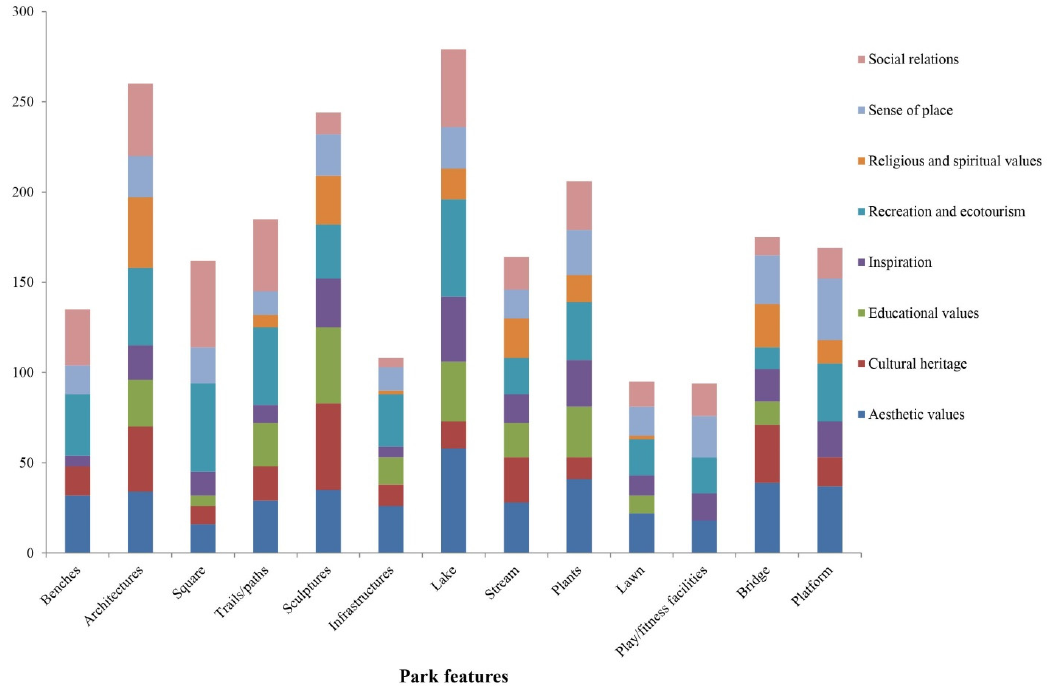
Figure 4. Counts of park features mentioned by interviewees that have effects on each